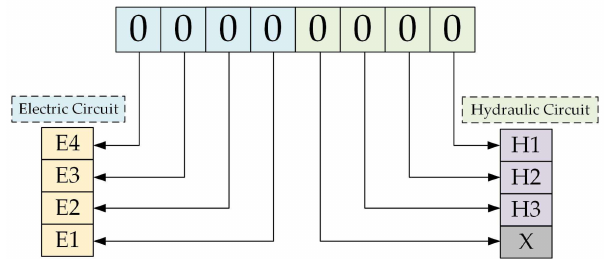
Figure 7. Binary encoding mode adopted in